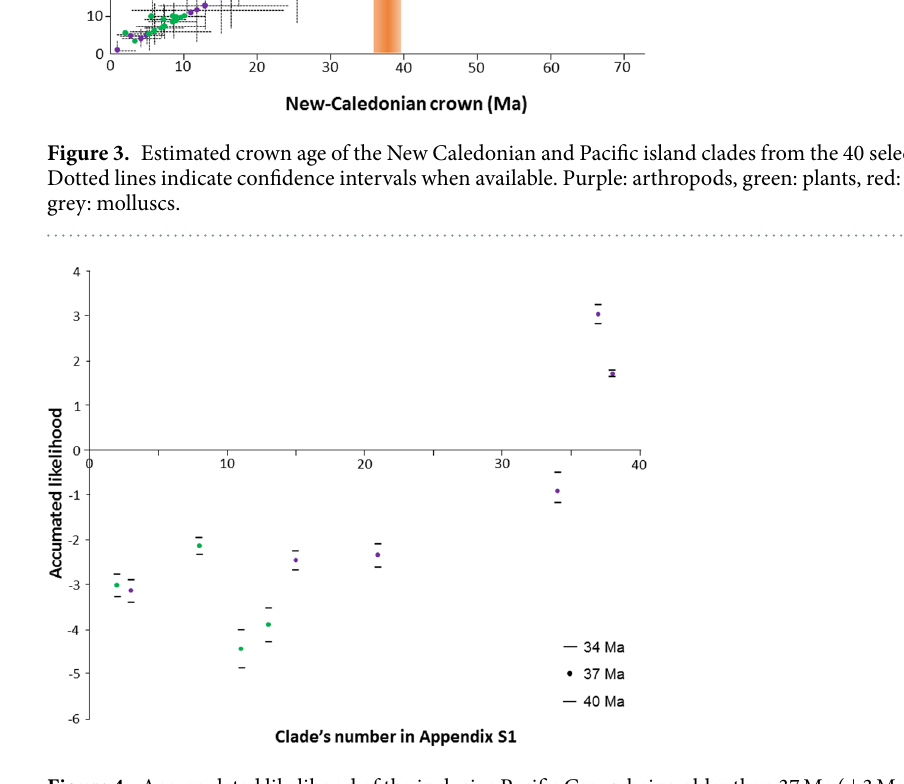
Figure 4. Accumulated likelihood of the inclusive Pacific Group being older than 37 Ma ( ± 3 Ma), from studies where crown age and Pacific insular age differ (n = 10). Numbers on the X-axis refer to the Clade ID in Table 1. Purple: arthropods, green: plants, red: vertebrates, grey: